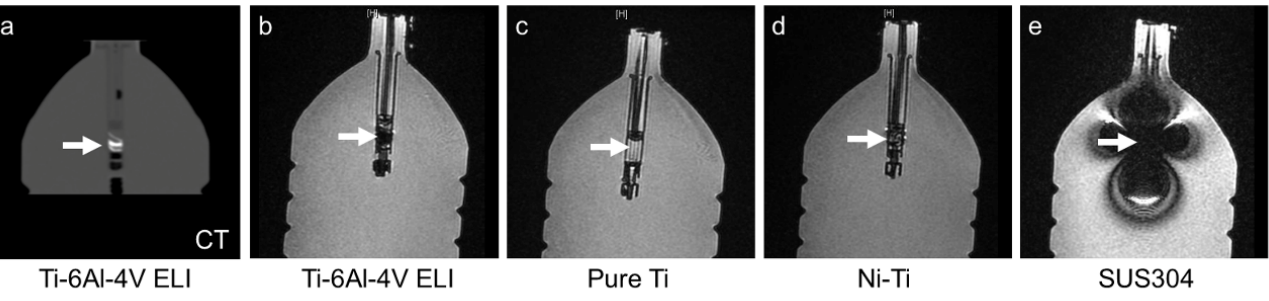
Figure 2. Comparison of the images of metal wires in the phantom on MRI (3.0-Tesla). ( a ) CT image of Ti alloy (Ti-6Al-4V ELI, Ø 0.21 mm) used in our reinforced endotracheal tube. To evaluate the susceptibility artifacts of various metal wires, coronal T1-weighted MRI of helical metal wires ( b – e ) was performed: ( b ) Ti alloy (Ti-6Al-4V ELI, Ø 0.21 mm) used in our reinforced endotracheal tube, ( c ) pure Ti (Ø 0.1 mm), ( d ) Ni-Ti alloy (Ni-Ti, Ø 0.1 mm), and ( e ) SS (SUS304, Ø 0.1 mm). The white arrows show the helical wires inside the tip of the 2.5-mL polypropylene syringes.